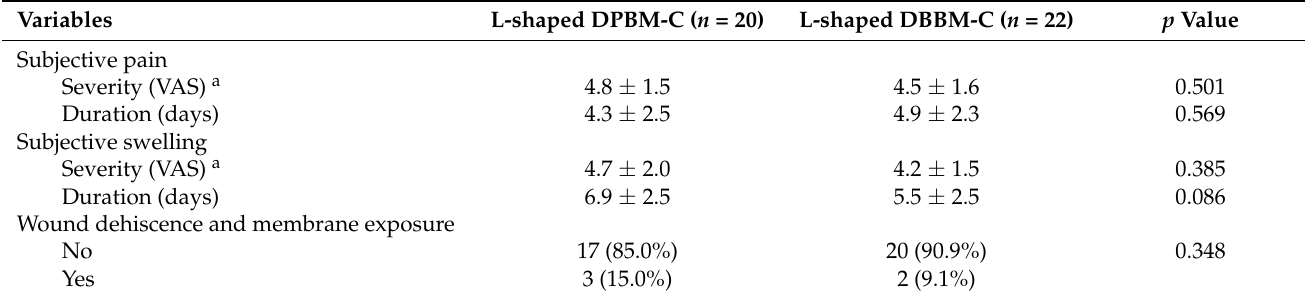
Table 3. Postoperative discomfort and early wound healing